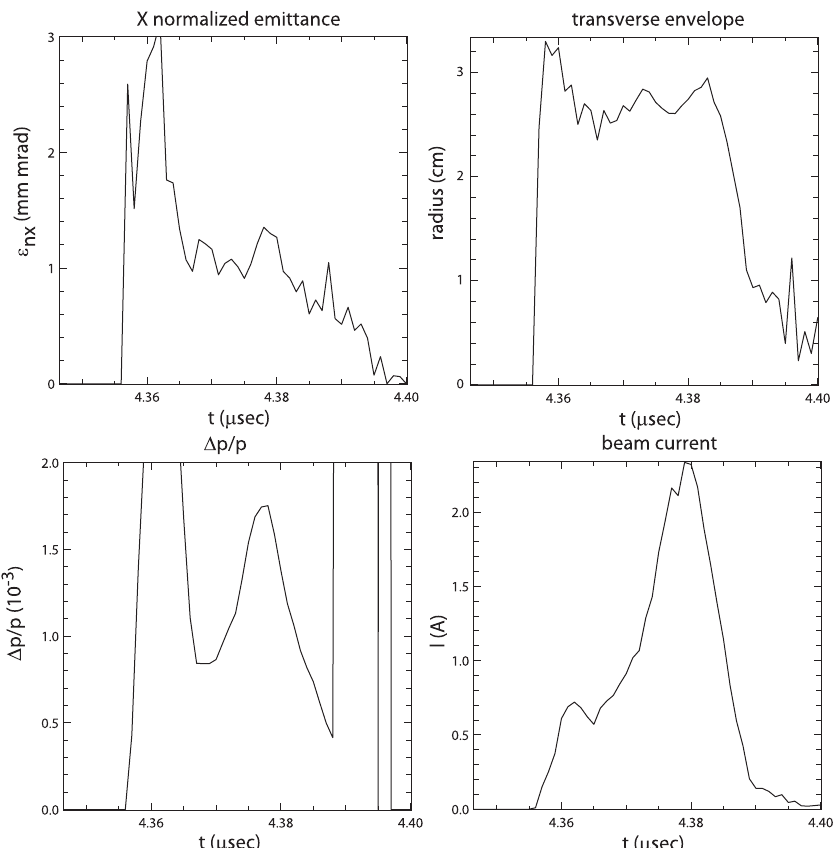
FIG. 15. Key moments of the ion beam as functions of time, measured at z ¼ 17 : 5 m , which is just before the entrance of induction for voltage